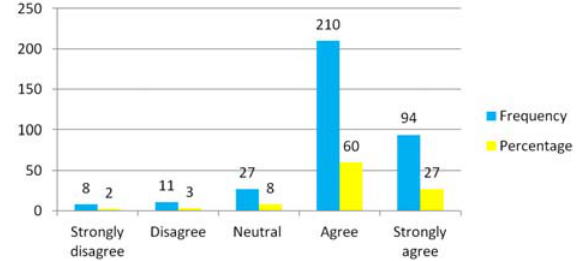
Fig. 4. Respondents’ statements on youth entrepreneurial limiting factors